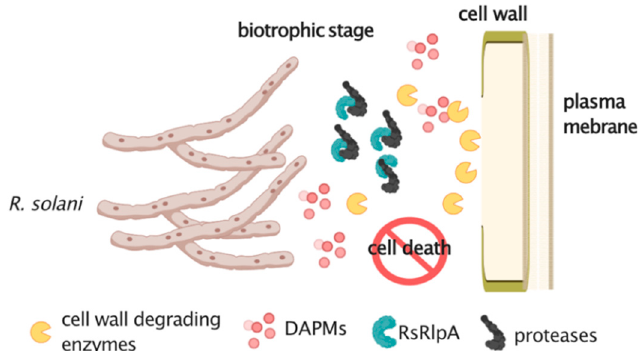
Figure 8. Proposed function of the RsRplA effector during plant infection. Carbohydrate active enzymes degrade the plant cell wall and produce damage-associated molecular patterns (DAMPs) able to induce pattern-triggered immunity (PTI). The RsRplA e ff ector could be deployed by R. solani to perturb protease activity suppressing hypersensitive response during an initial biotrophic stage. This is followed by activity of cell wall degrading enzymes leading to the onset of the necrotrophic stage. Figure created by the Biorender